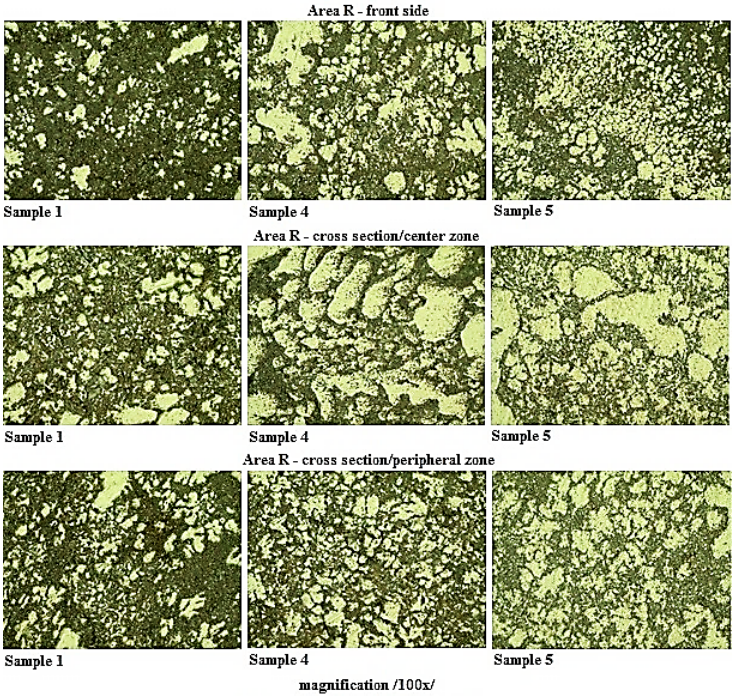
Figure 6. Structure in the scratch pattern location of samples taken from the R Area.